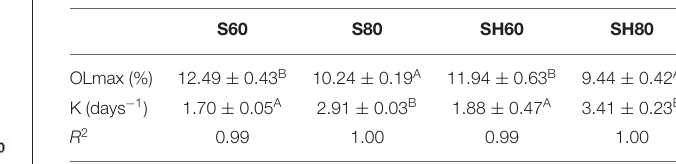
TABLE 1 | Kinetics parameters of the oil